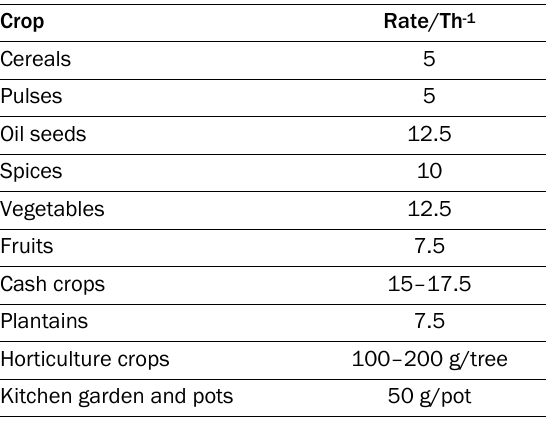
Table 2. Recommended Vermicast